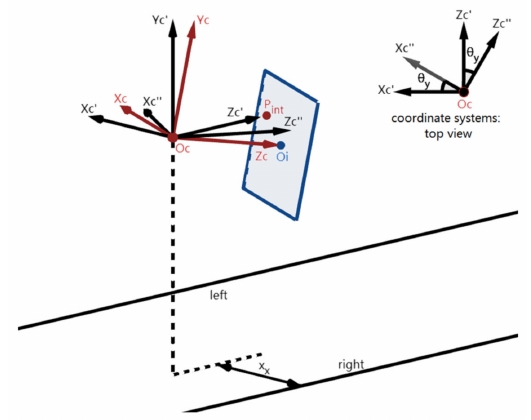
Figure 10. The side and top view of the coordinate